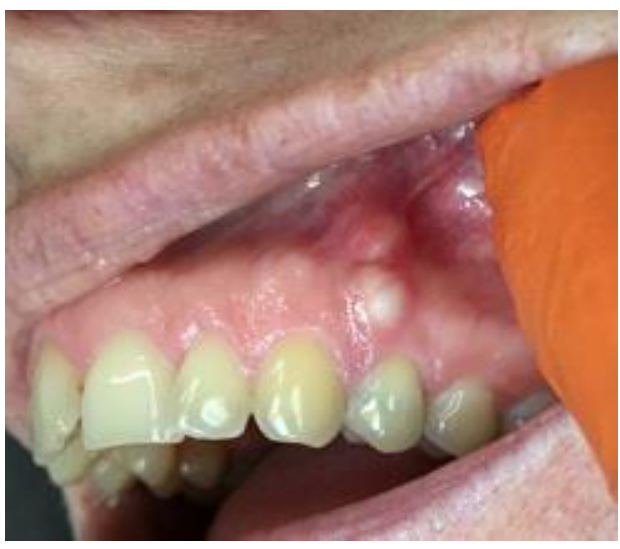
Figure 2. LPC expanding towards attached gingiva with buccal cortical plate resorption.